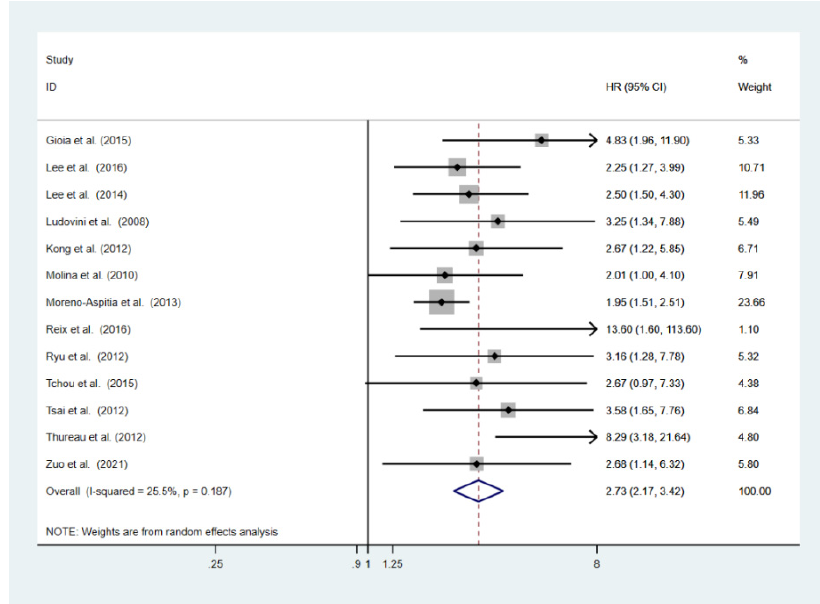
Figure 3. Forest plot of the HR for the DFS from the eligible studies [9,13,29,37,38,43,46,50,51,55–57,60].